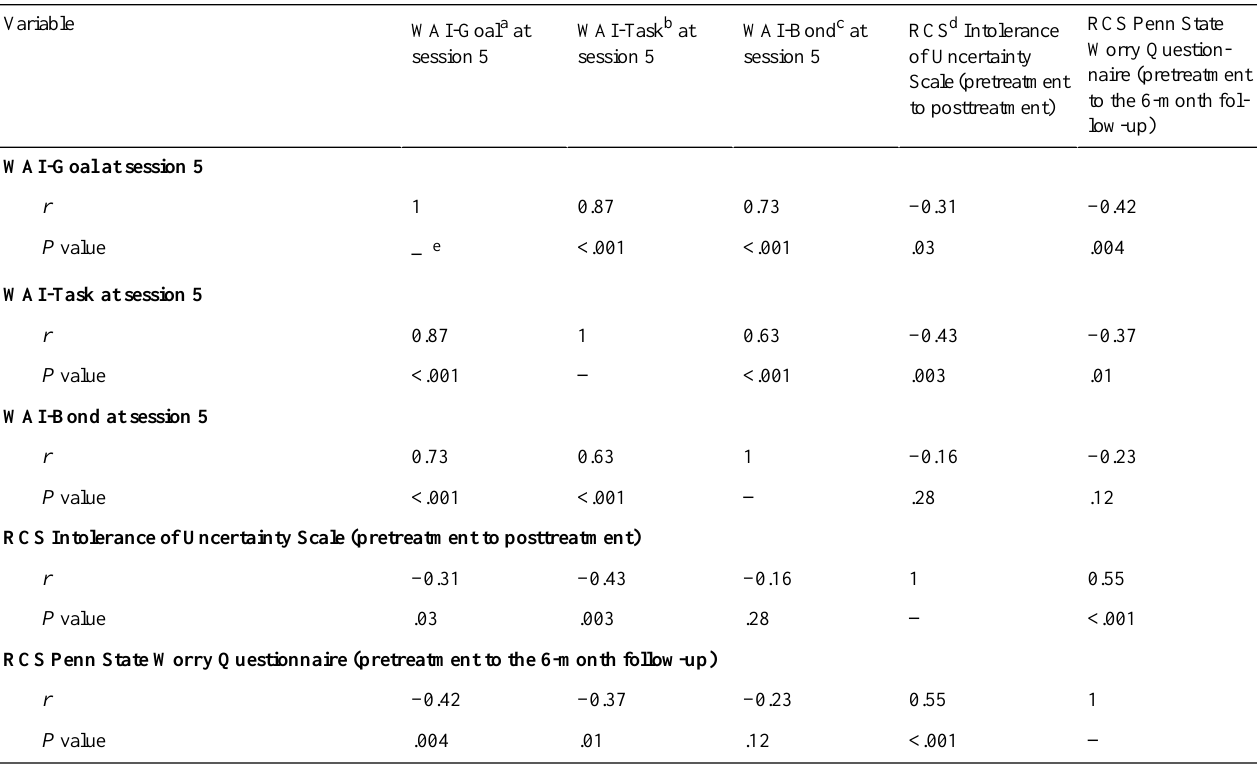
Table 2. Correlation matrix (Pearson r and two-tailed P value) of all study measures during cognitive behavioral treatment for generalized anxiety disorder delivered by videoconference (N=46).